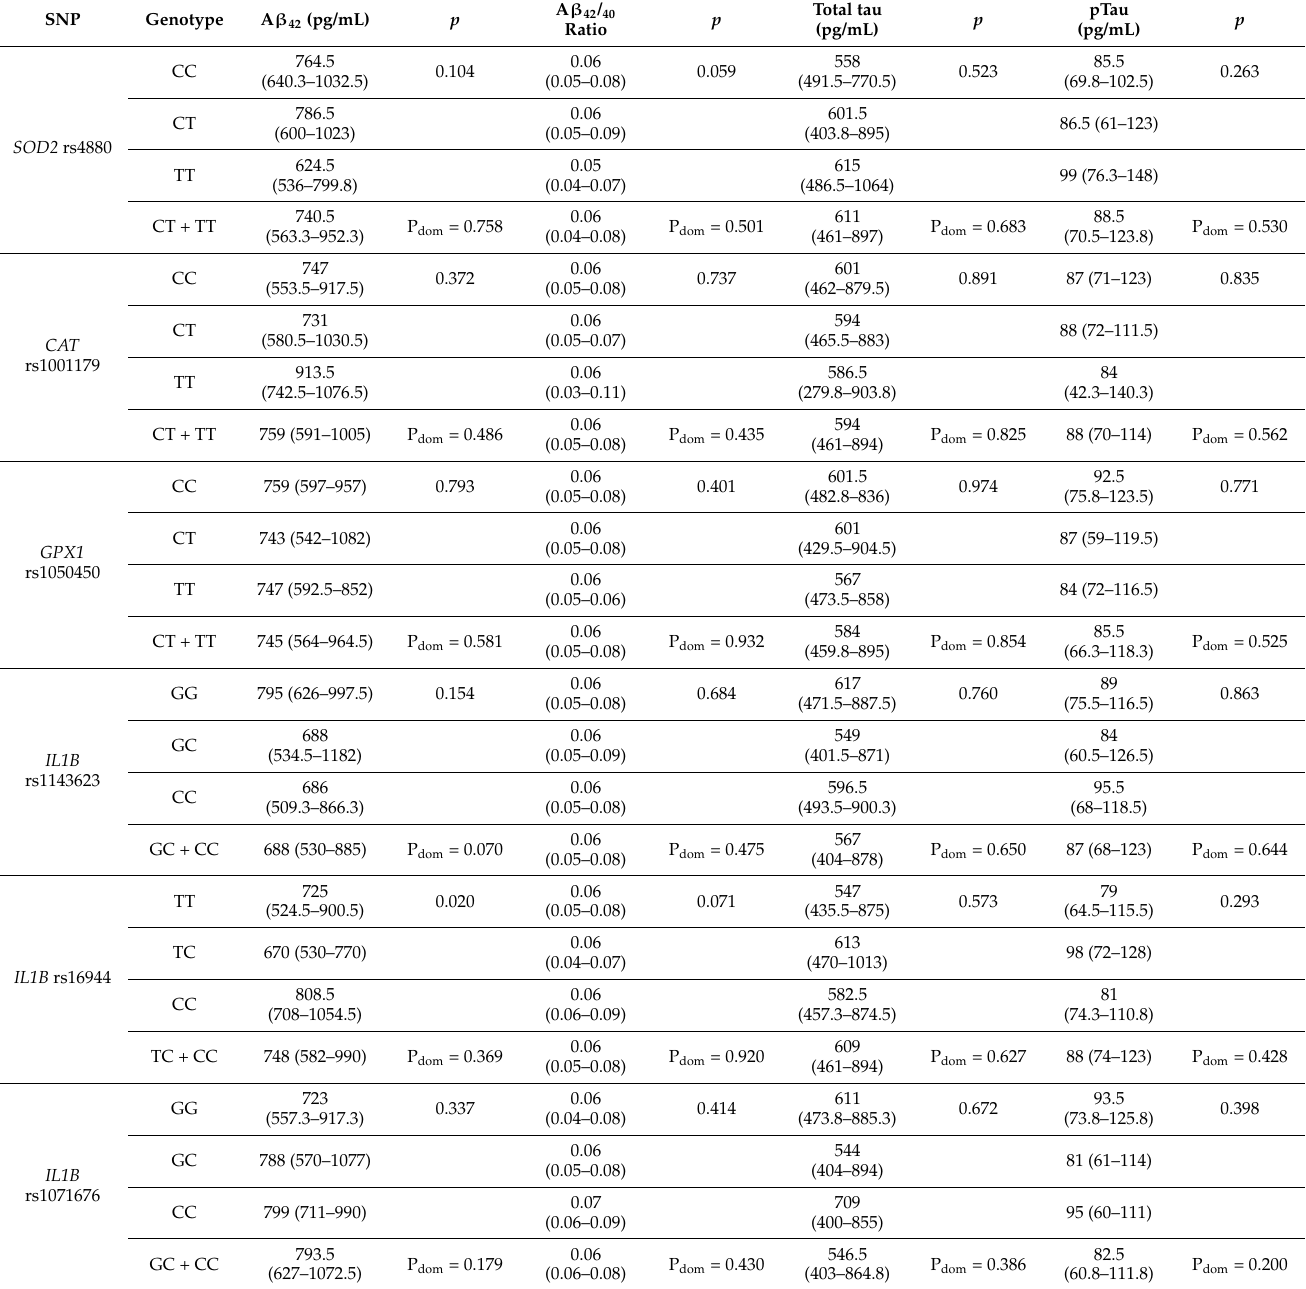
Table 3. Association of investigated polymorphisms with cerebrospinal fluid biomarkers among all patients with